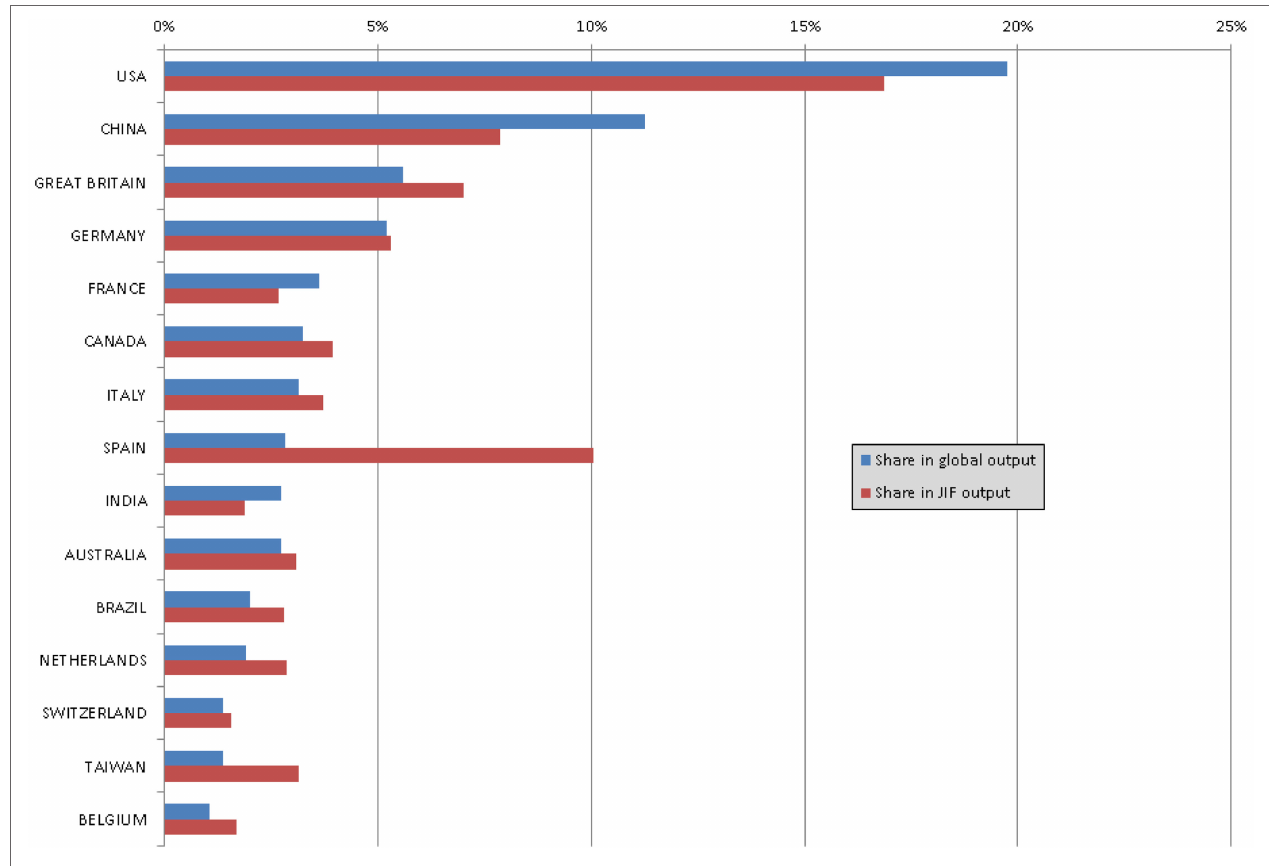
FigUre 3 | comparing output shares on Journal impact Factors (JiFs) and global science, 2011–2015